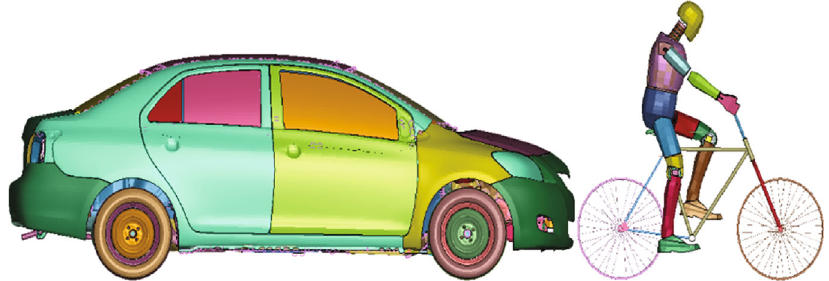
Figure 1: Initial position cyclist/automobile.